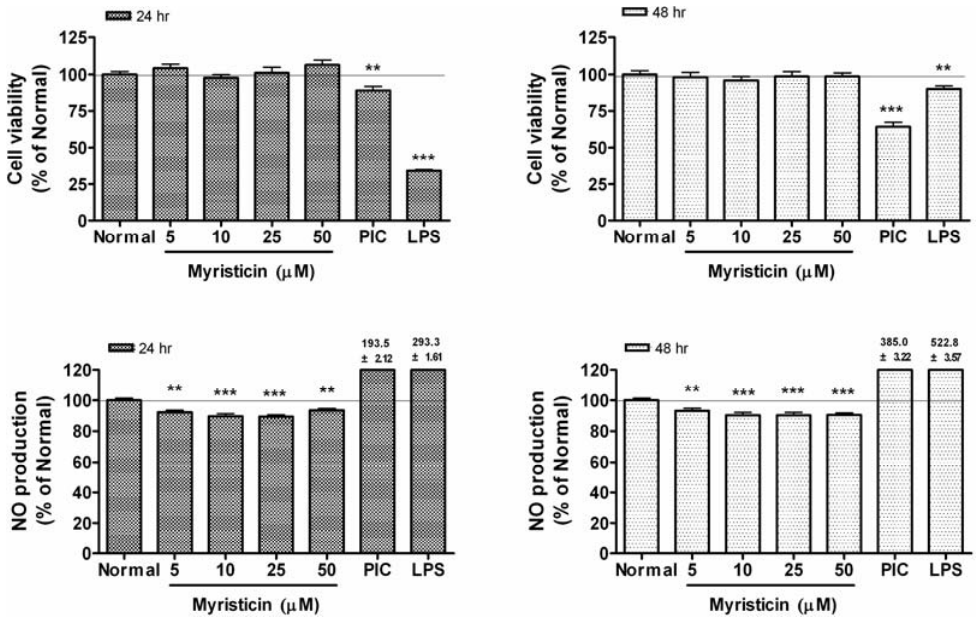
Figure 2. Effects of myristicin on the cell viability and NO production in RAW 264.7 mouse macrophages. After 24 and 48 h incubation with myristicin, cell viability was evaluated by a modified MTS assay and NO production was measured by the Griess reaction assay in RAW 264.7 cells. Normal group (Normal) was treated with media only. The synthetic analog of dsRNA (PIC, 50 µg/mL of polyinosinic-polycytidylic acid) and lipopolysaccharide (LPS, 1 µg/mL) were used as reference materials. Values are the mean ± SEM of three independent